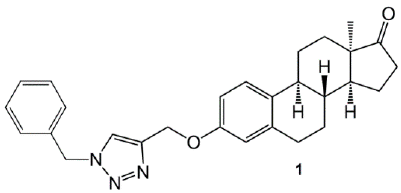
Figure 1. Structure of 3- O -[(1-benzyl-1 H -1,2,3-triazol-4-yl)methyl]-13 α -estrone.